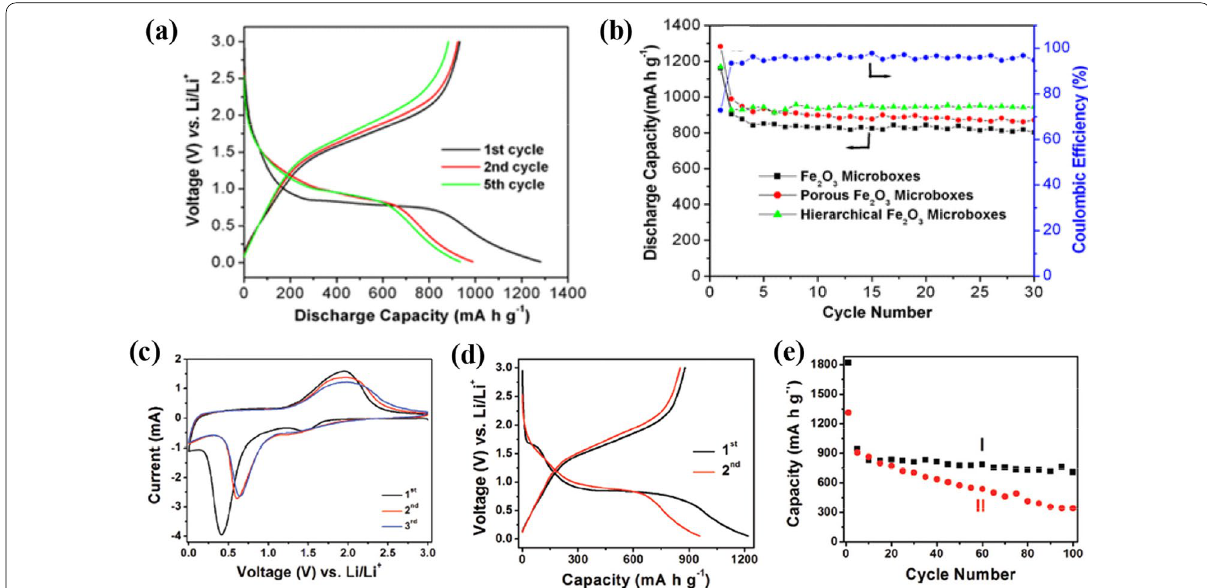
Fig. 8 a Discharge charge voltage profiles of porous Fe 2 O 3 microboxes obtained at 550 °C. b Cycling performance of Fe 2 O 3 microboxes (350 °C), − porous Fe 2 O 3 microboxes (550 °C), and hierarchical Fe 2 O 3 microboxes (650 °C) and Coulombic efficiency of porous Fe 2 O 3 microboxes (550 °C) over the voltage range 0.01 3.0 V vs. Li/Li + at the same current density of 200 mA g -1 . ( a , b Reprinted with Permission from [54]. Copyright, − American Chemical Society). Electrochemical measurements of the sample. c CVs between 5 mV and 3 V at a scan rate of 0.5 mV s − 1 . d